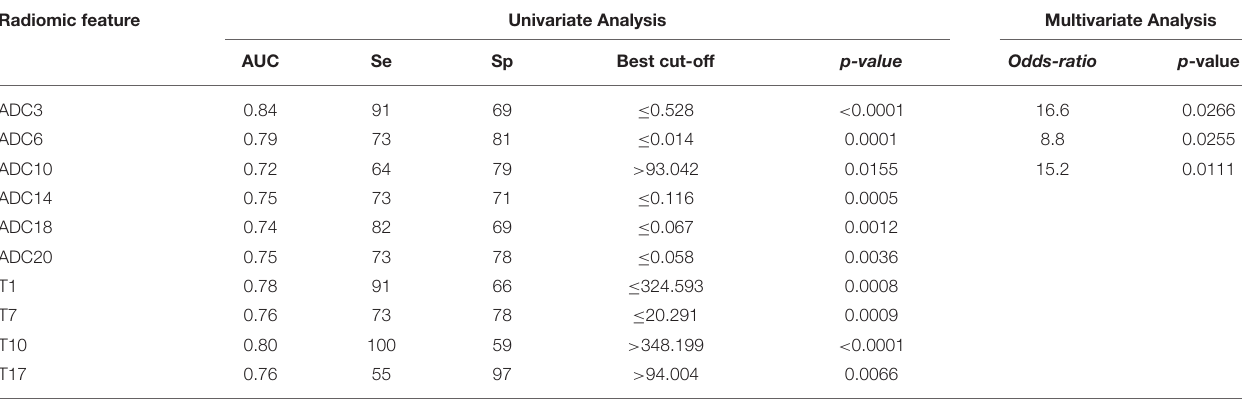
TABLE 4 | Correlation between radiomic features and biochemical recurrence. Radiomic feature Univariate Analysis